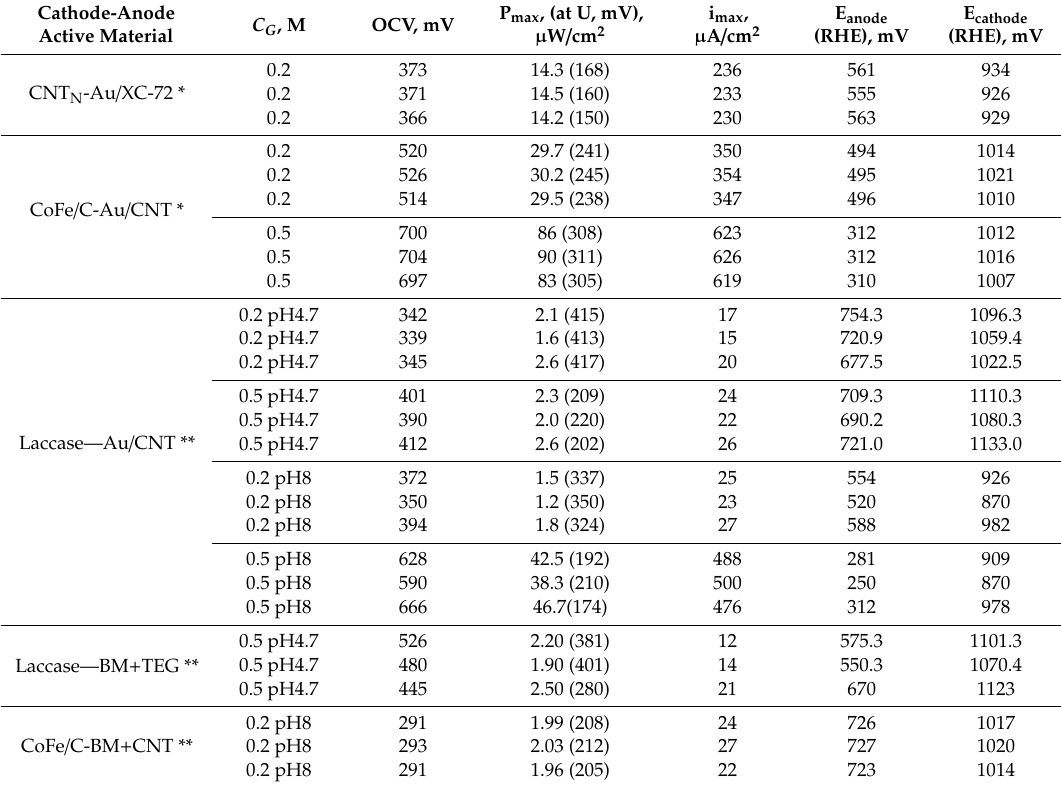
Table 1. Test results of membraneless glucose-oxygen FC * and BFC **.